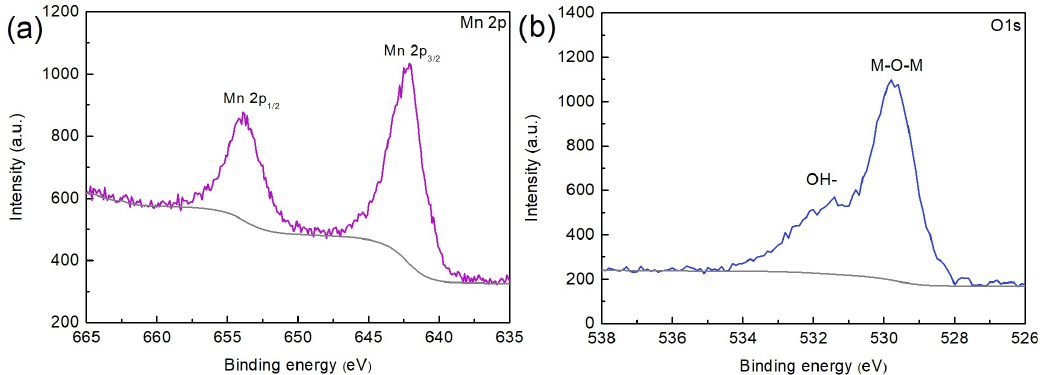
Figure 4. XPS spectra Mn 2p ( a ) and O1s ( b ) of manganese oxide nanolayers.